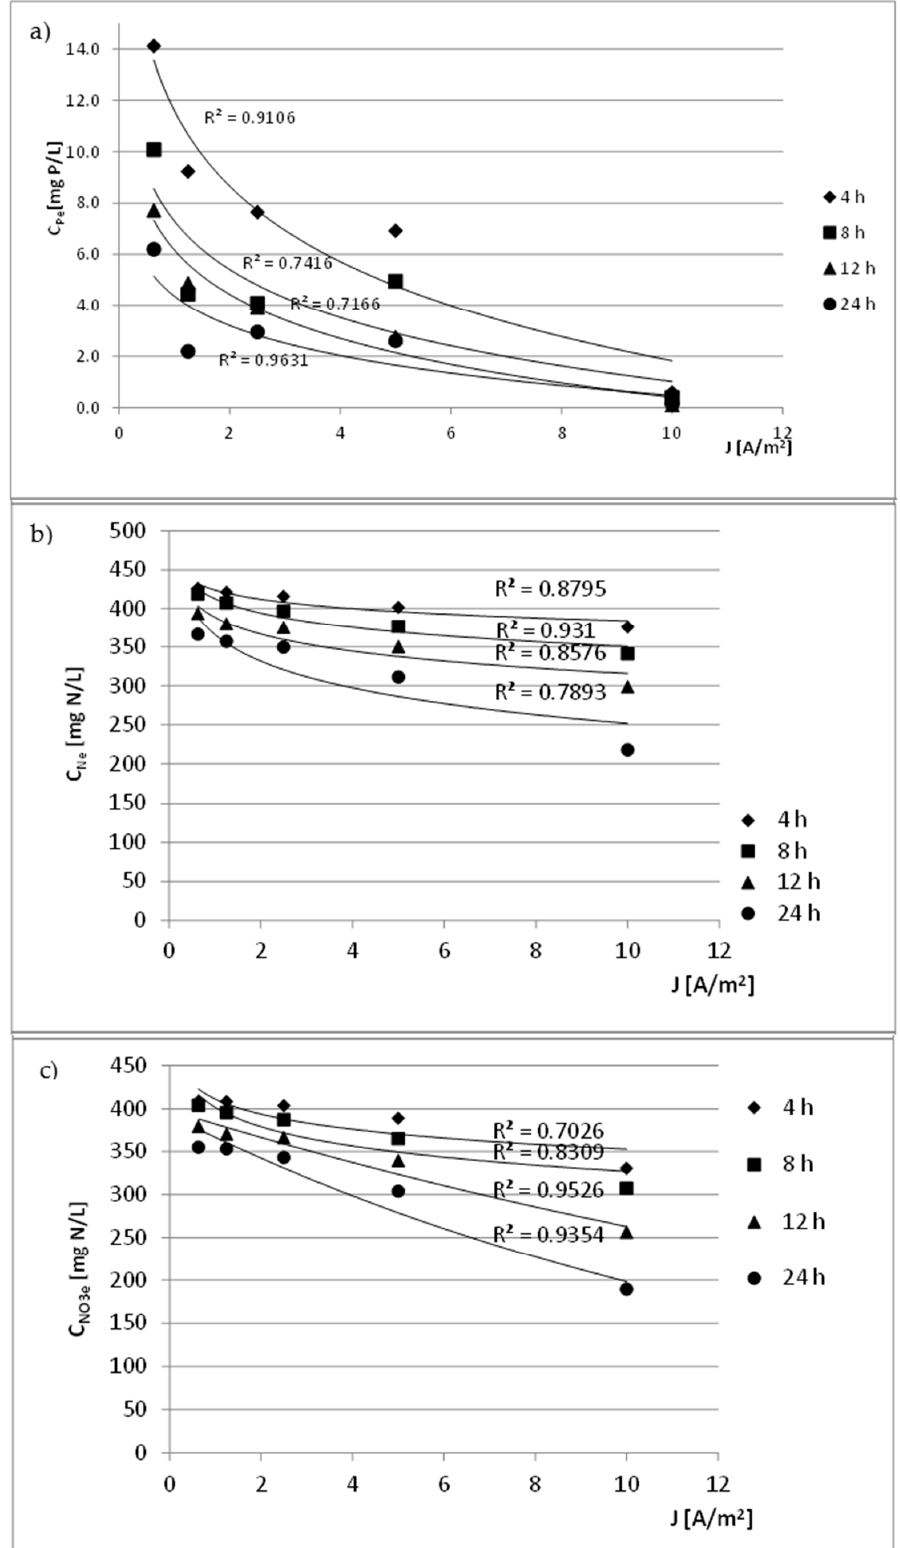
Figure 4. The influence of current density and HRT on the concentration of pollutants in the treated wastewater in the electrochemical rotating disc contactor (RECDC): ( a ) Phosphorus (C Pe ); ( b ) total nitrogen (C Ne ); ( c ) nitrates (C NO3e